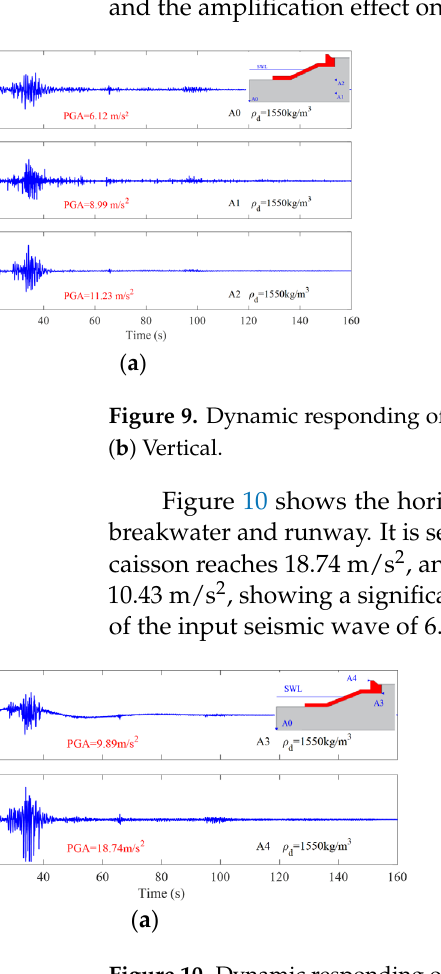
Figure 10. Dynamic responding of horizontal acceleration of the revetment breakwater and runway. ( a ) Revetment breakwater. ( b ) Runway.